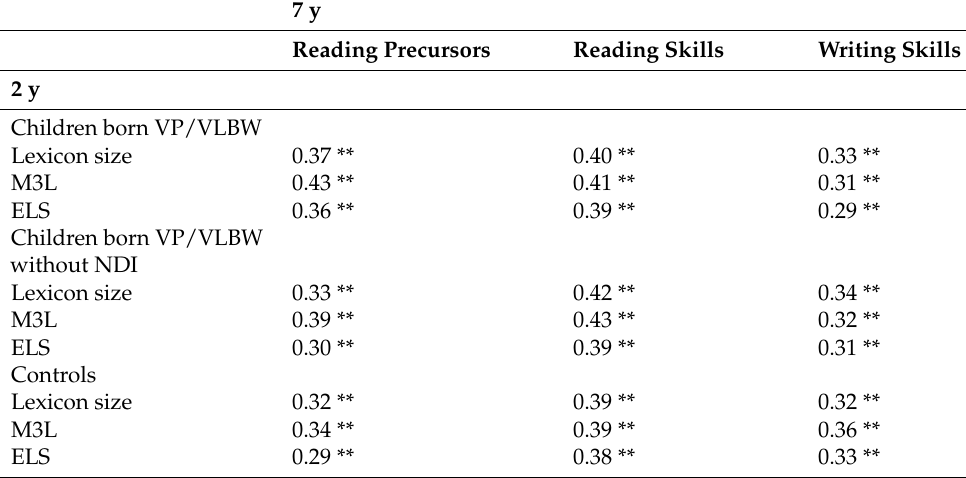
Table 3. Pearson correlation coefficient values ( r -values) between language measures at 2 years